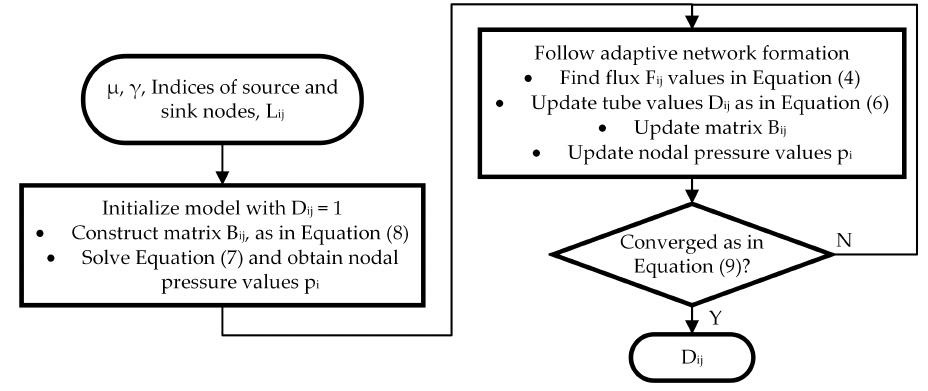
Figure 1. Flowchart of the slime mold